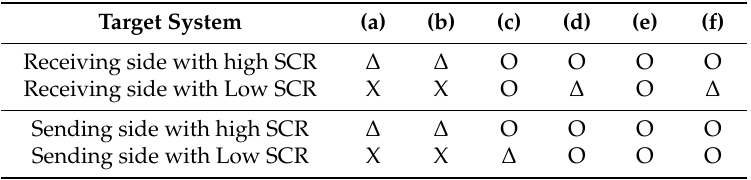
Table 5. Suitable control scheme for each TSO (O: Most suitable/ ∆ : Suitable/X: Not suitable). SCR: short circuit